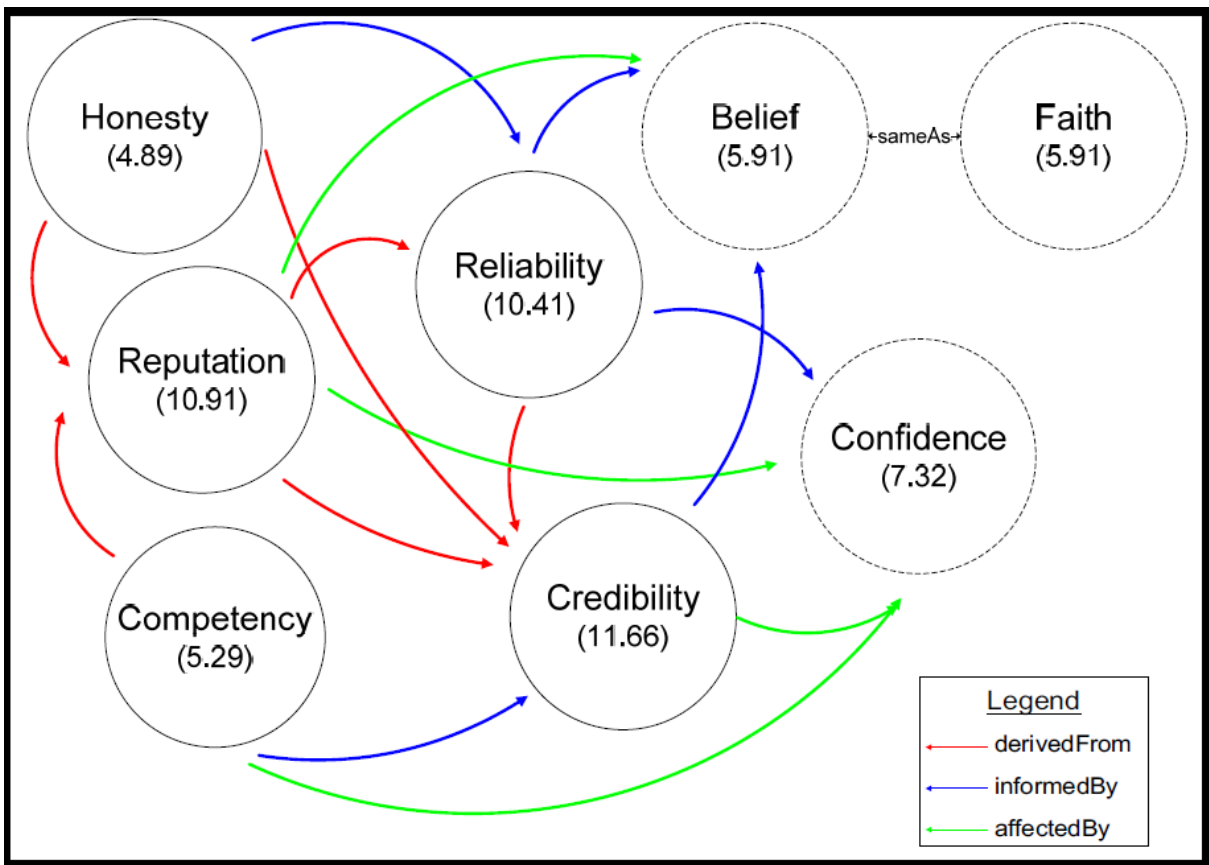
Figure 1. Personalized model of trustworthiness